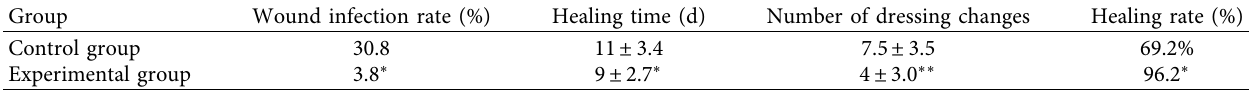
Table 3: Comparison of wound infection rate, healing time, and dressing change between the two groups of patients.